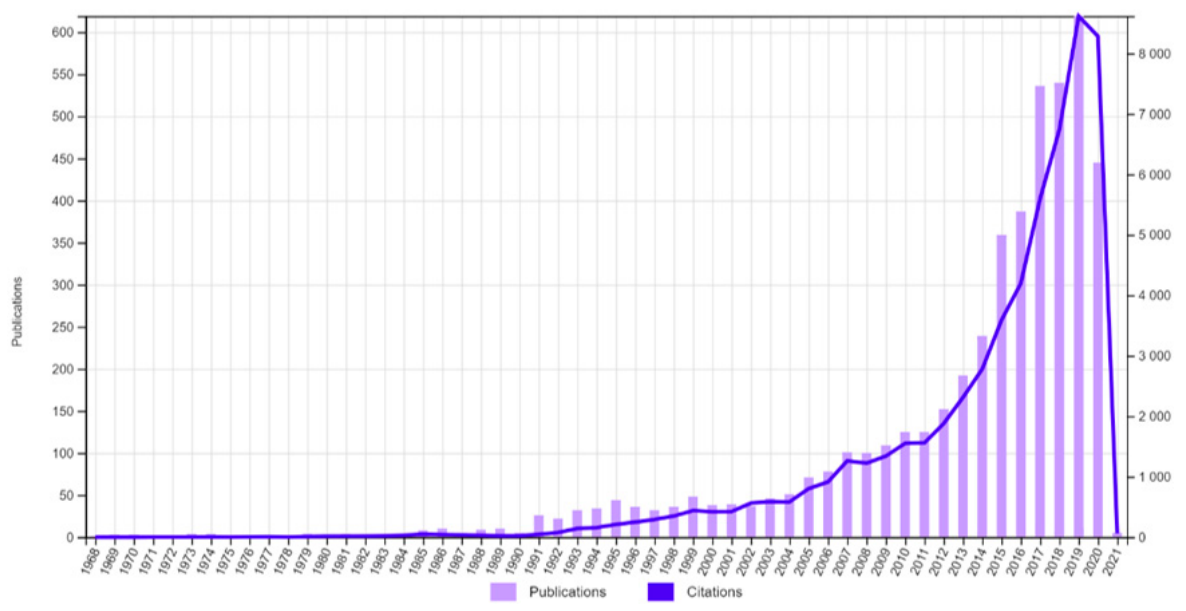
Figure 1. Web of Science publication and citation report, for the words “Photoplethysmography” OR “Photoplethysmogram” .